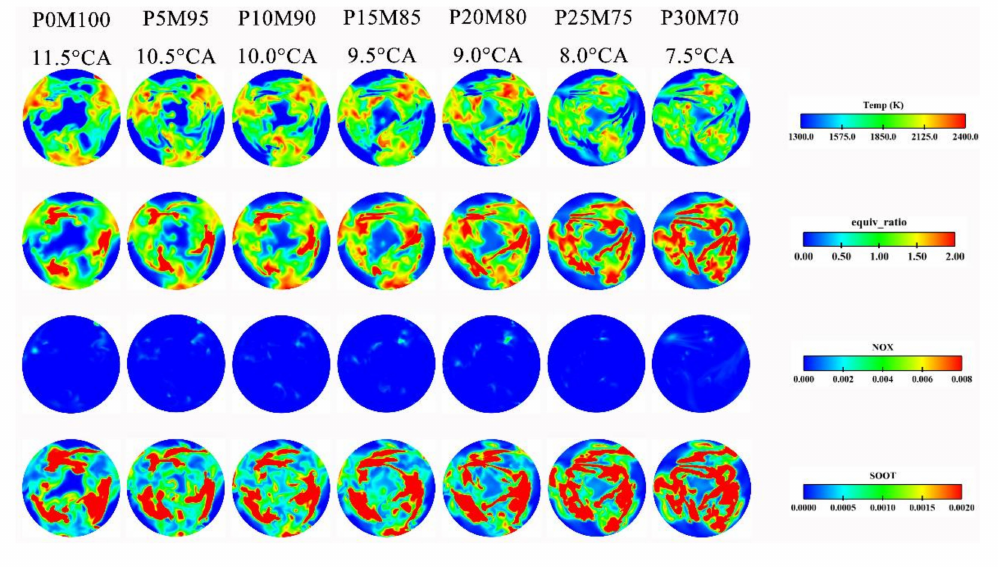
Figure 12. Impact of pilot injection mass ratio on the distribution of temperature, fuel-air equivalence ratio, NOx formation, and soot formation at the moment of 50% accumulative heat release (q50) for various injection cases.